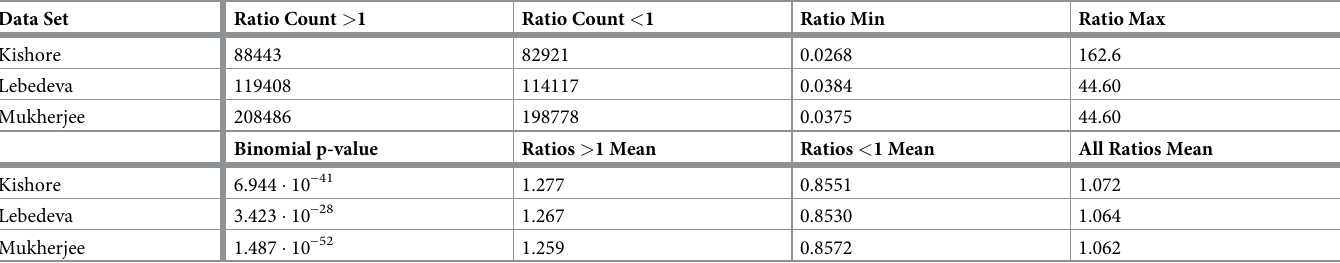
Table 1. Effects of SNPs on HuR binding affinity in 201 nucleotide sequences.